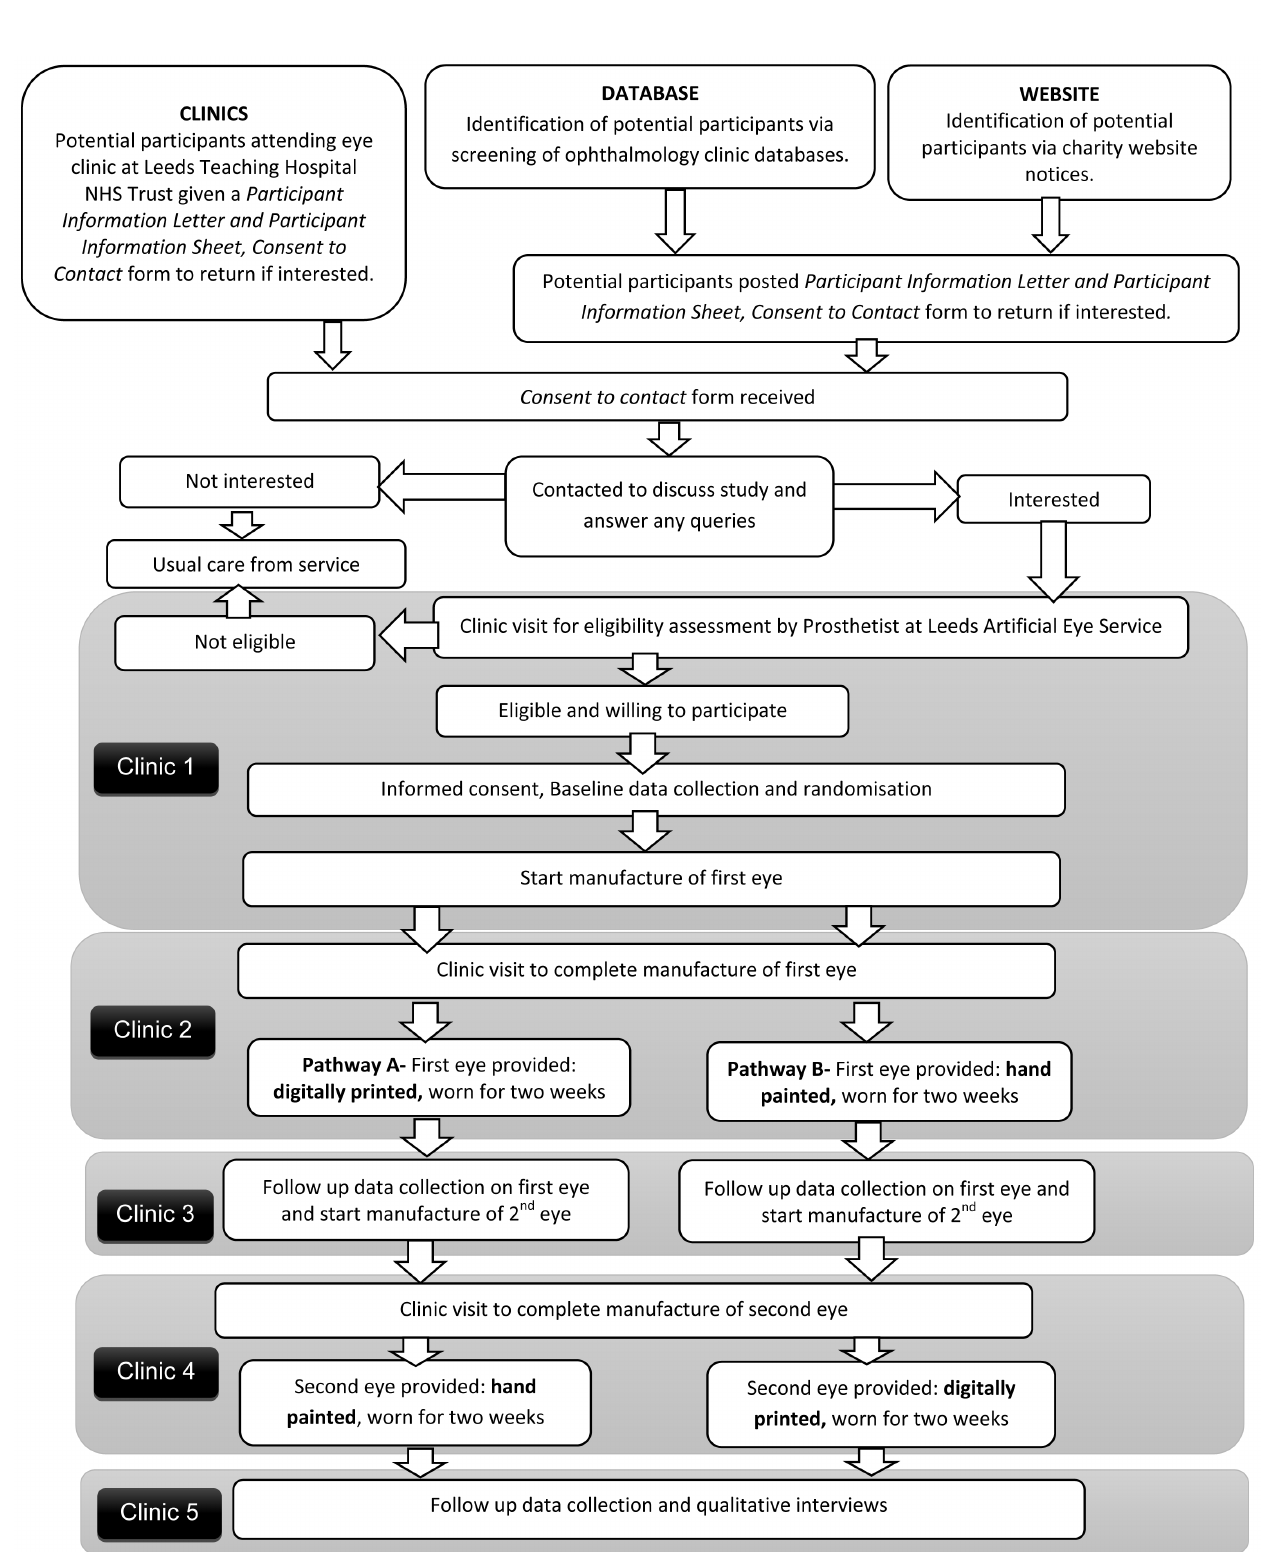
Figure 1. Summary of patient/participant